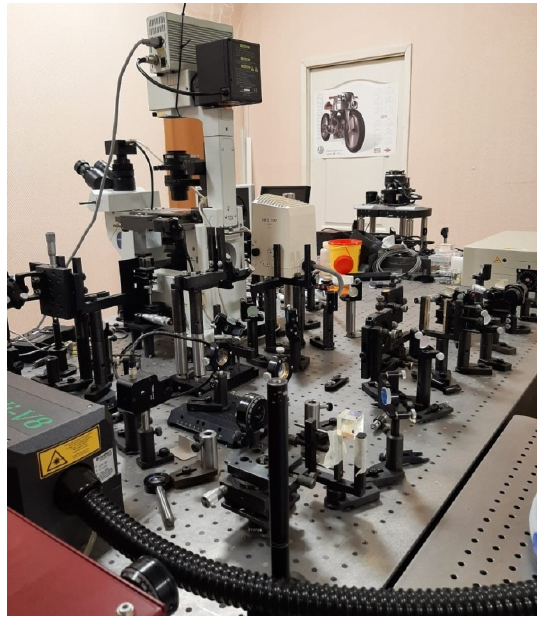
Figure 4. The irradiation setup.